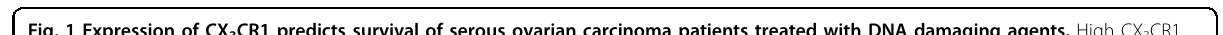
Fig. 1 Expression of CX 3 CR1 predicts survival of serous ovarian carcinoma patients treated with DNA damaging agents. High CX 3 CR1 expression predicts shorter overall (OS) and progression-free (PFS) survivals of serous ovarian carcinoma patients treated with platinum therapies ( a ), gemcitabine ( b ), and topotecan ( c ). OS and PFS of serous ovarian carcinoma patients were analyzed using KM Plotter database. Red lines — high CX 3 CR1, black lines — low CX 3 CR1. Numbers of specimens with high (red) and low (black) CX 3 CR1 for each analyzed group and their corresponding average survival are shown in the tables. The best performing threshold was used to determine CX 3 CR1-low and CX 3 CR1-high groups of specimens using KM Plotter software. Expression of CX 3 CR1 in examined specimens is plotted as beeswarm plots shown as inserts; red — high CX 3 CR1, black — low CX